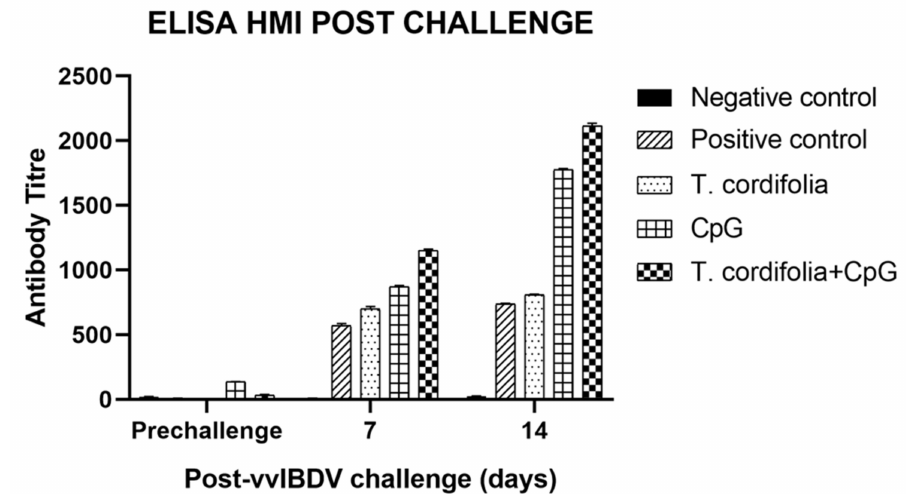
Figure 4. Serum antibody titer in chickens challenged with vvIBDV at di ff erent DPC by ELISA kit method (antibody titer is expressed as mean ± SE of antilog of Log 10 titer).